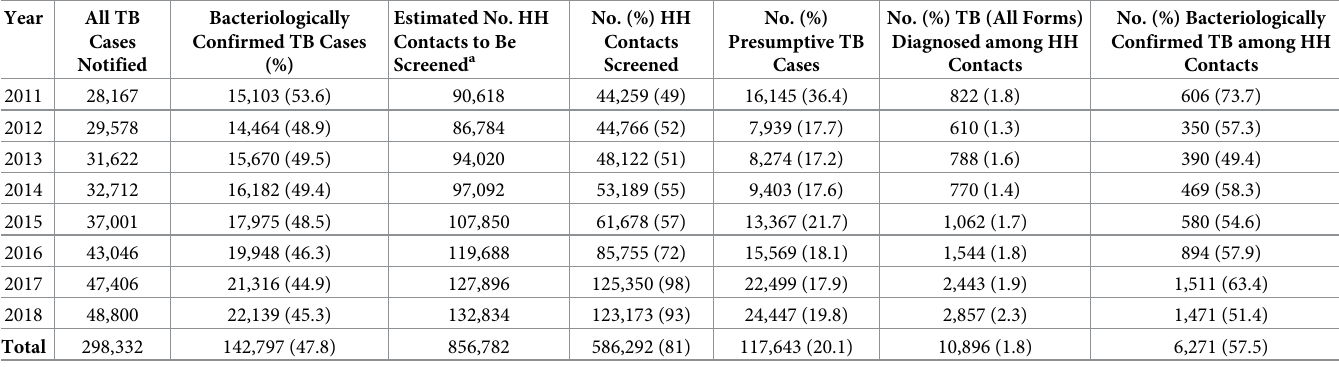
Table 1. Trends and yield of household contact